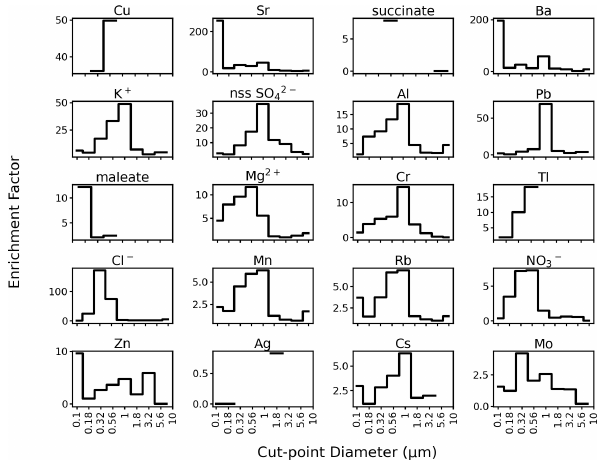
Figure 6. Size-resolved enrichments for individual firework tracer species in order of decreasing total bulk mass concentration enrich- ment (species from Fig. 5). Cut-point diameters with no valid data are left blank. The y axis of Sr and Ba is truncated to more eas- ily show enrichments in the larger size fractions. Figure S6 shows similar results for all other